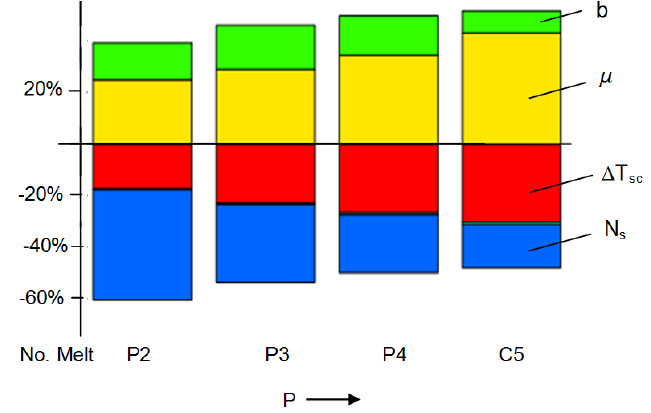
Figure 21. Phosphorous intensity effect on the CT index, through μ, N s , b ,  T sc and f (− CT decreases; + CT